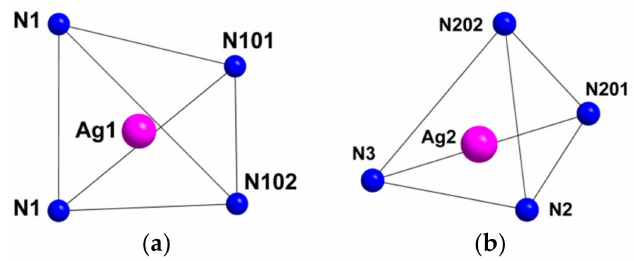
Figure 3. Coordination polyhedra of Ag1 ( a ) and Ag2 ( b )